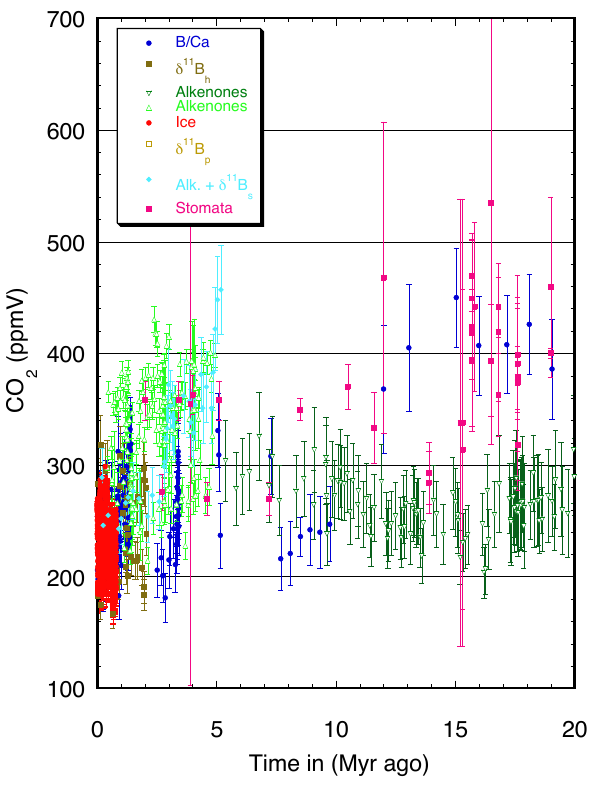
Fig. 3. CO 2 records as a function of time, indicating the inhomo- geneous distribution in amount and range for the different proxies. Data are B/Ca (Tripati et al., 2009), stomata data (K¨urschner et al., 1996, 2008; Retallack 2009), alkenones with δ 11 B s (Seki et al., 2010), δ 11 B p (Pearson and Palmer, 2000), δ 11 B h (H¨onisch et al., 2009), alkenones (Pagani et al., 2005, 2010) and ice (Petit et al., 1999; Siegenthaler et al., 2005; L¨uthi et al., 2008). The symbols and colours for the different proxies are similar in all figures. Alkenone data by Pagani et al. (2005, 2010) are treated as two datasets in order to test whether one of the two could be used for further analysis.